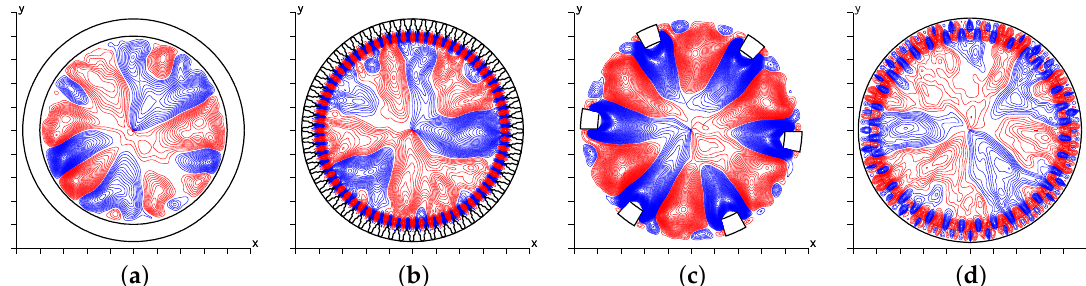
+ V r ), for smooth pipe SM ( a ); trian- b